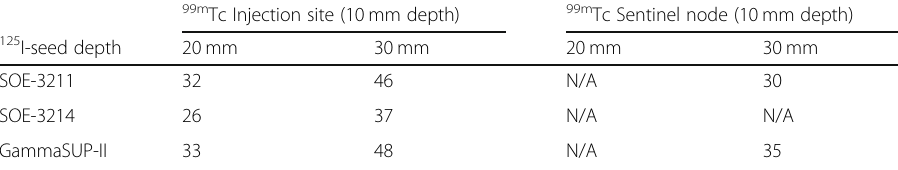
Table 5 Shift Index (mm) from clinical simulations for the three